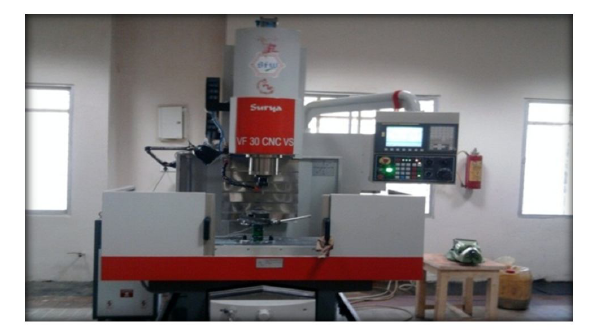
Fig. 1. Experimental set up for the drilling